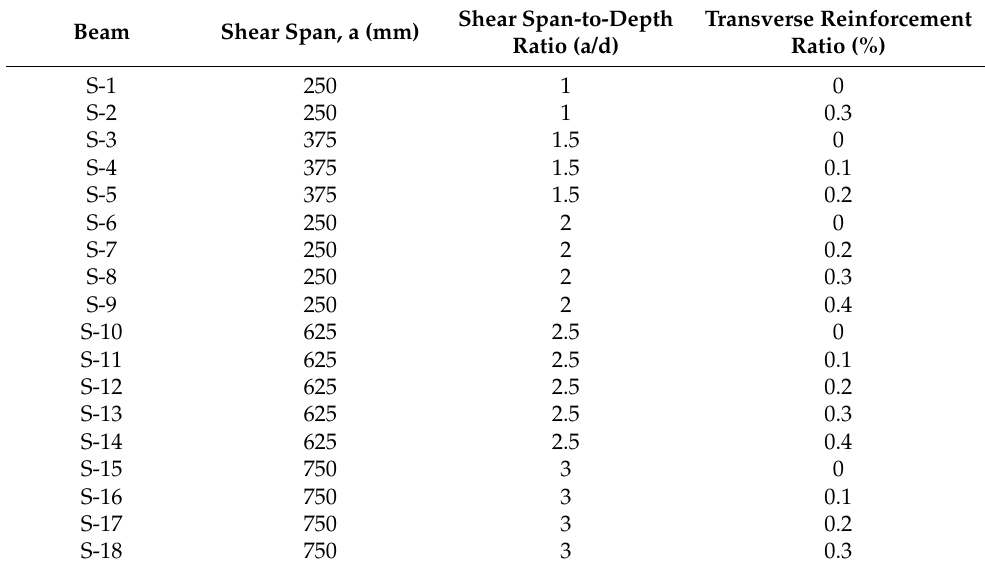
Table 6. Details of the simulated beam specimens.